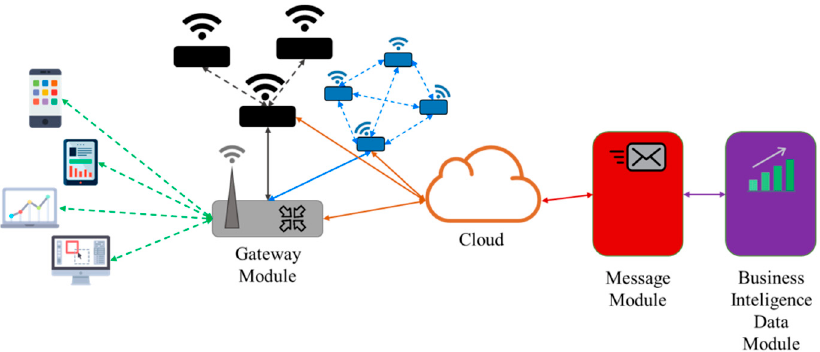
Figure 12. Proposed architecture.